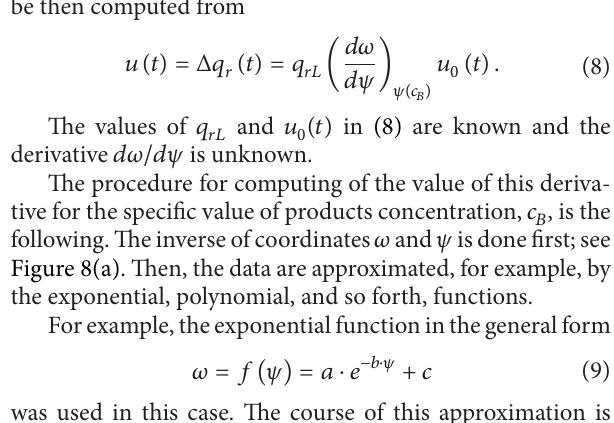
means in this case that lower and upper bounds of the input variable and equivalent values of the concentrations